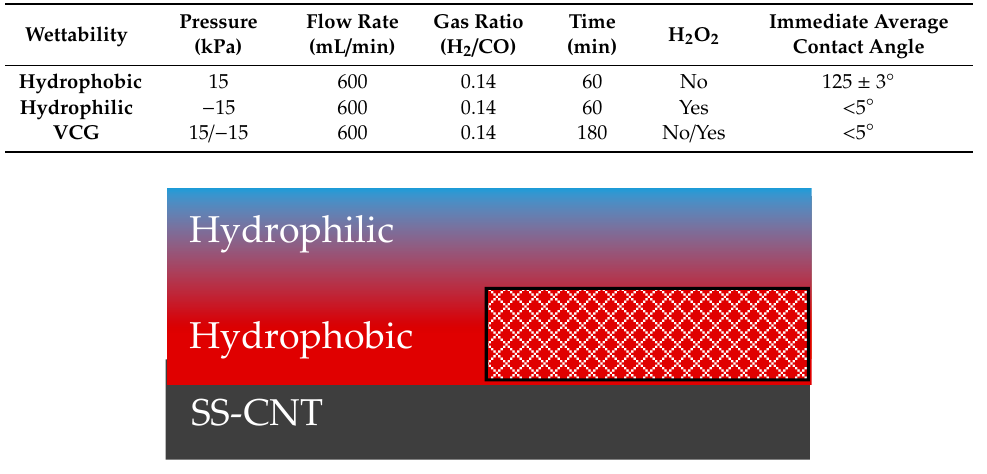
Figure 1. Schematic of the PICVD VCG (Photo-initiated chemical vapor deposition vertical chemical gradient) formed by a cross-linked hydrophobic layer beneath a hydrophilic coating.